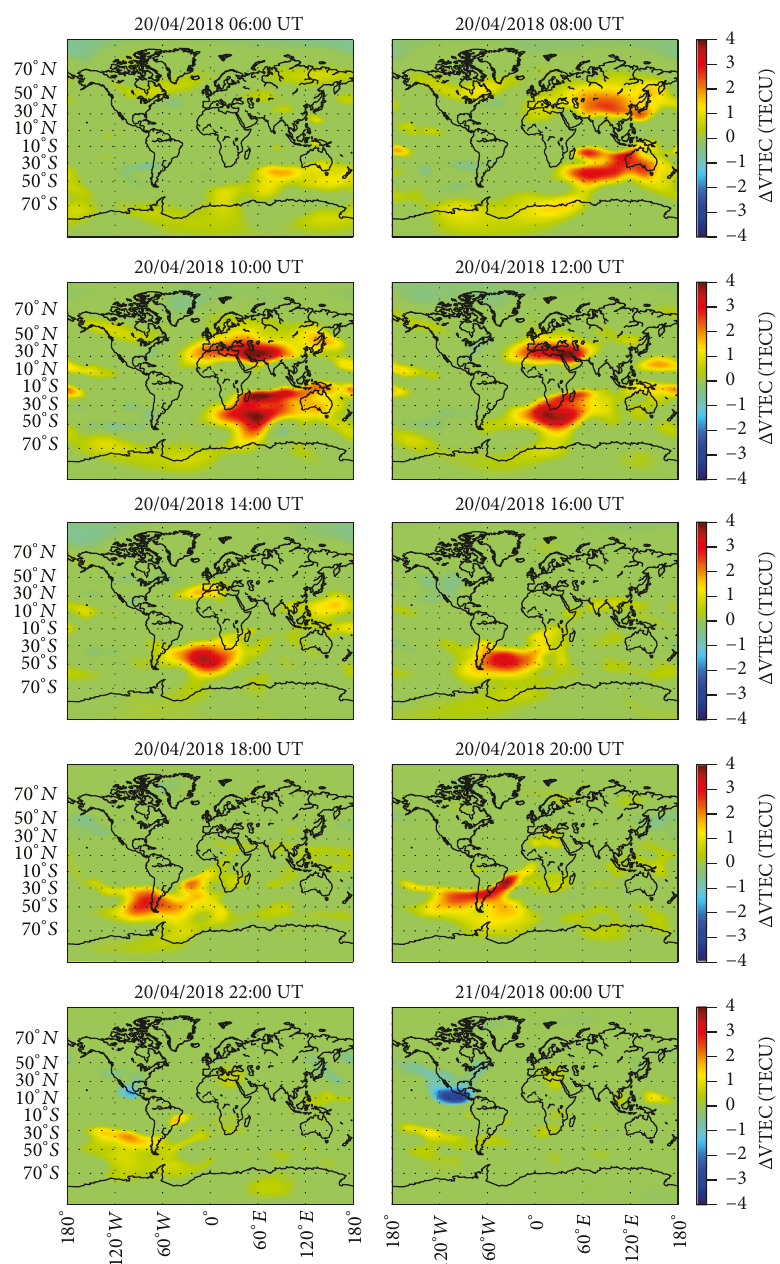
Figure 3: Differential VTEC maps between April 20, 2018 (06:00 UT), and April 21, 2018 (00:00